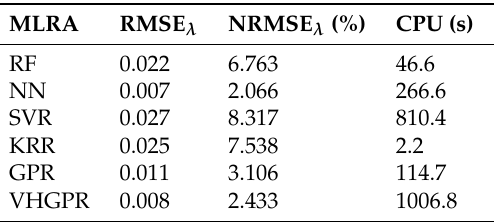
Figure 1. SCOPE NRMSE [%] results for the MLRAs validation for 30% of 500 SCOPE R outputs using 20 PCA conversion. Table 3. MLRA emulators validation results (RMSE λ , NRMSE λ ) and training and validation processing time (s: seconds) for 30% of 500 SCOPE R outputs and using 20 PCA